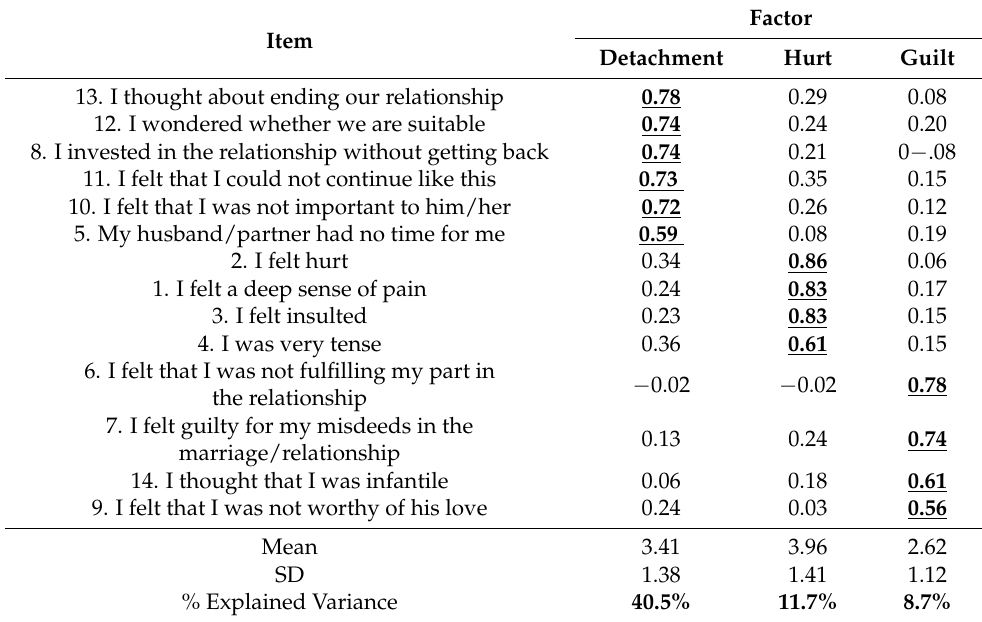
Table 3. Factor loadings and statistics of the loneliness in intimate relationships second 14-item version—Study